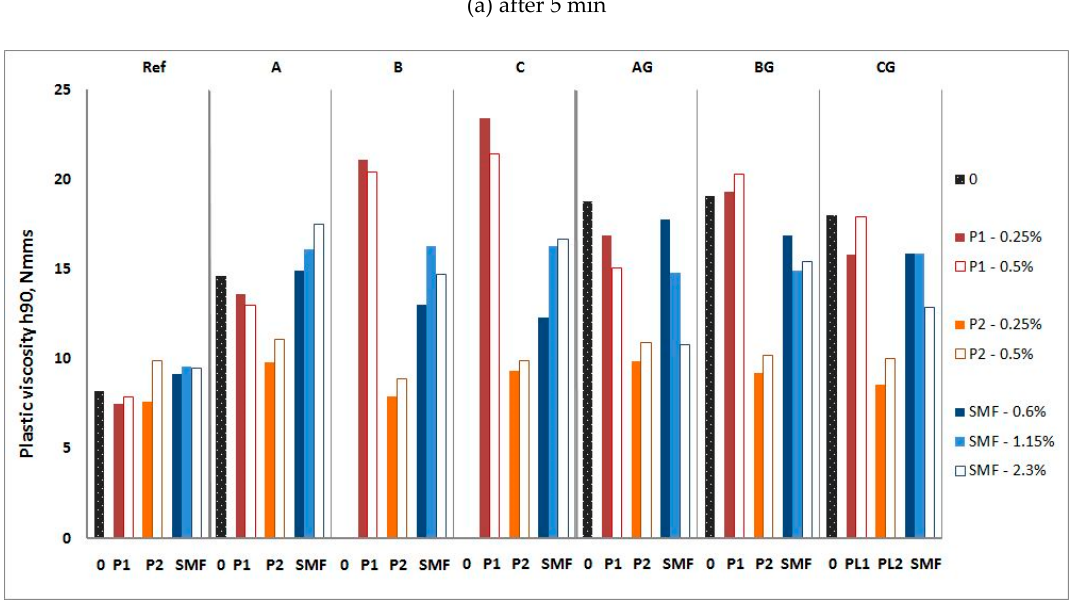
Figure 11. Influence of P1 and P2 and SMF on plastic viscosity h of mortars with raw and ground CFA. ( a ) after 5 min; ( b ) after 90 min.